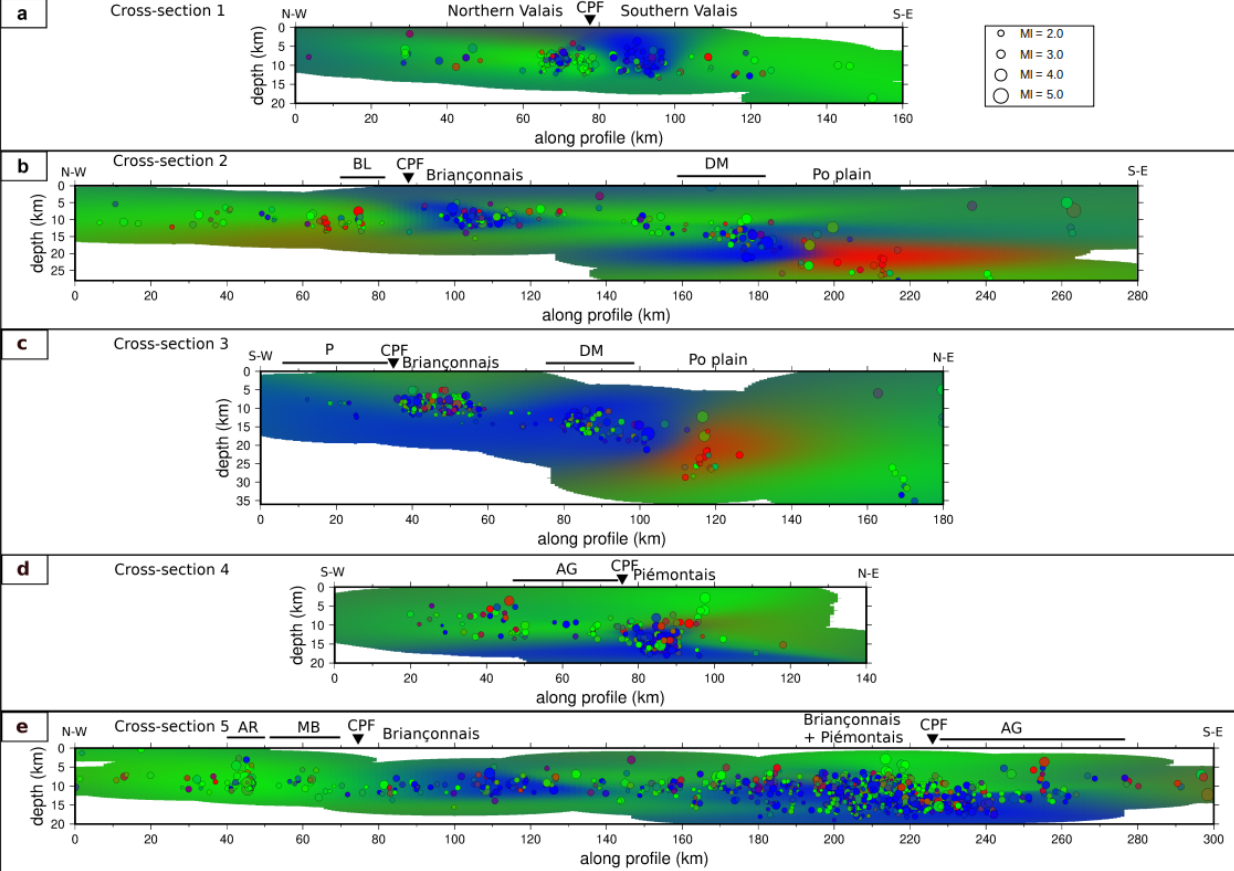
Figure 9. Vertical cross sections displaying averages of P , T , and B distributions from the Bayesian interpolation of events projected along five profiles. Focal mechanisms used are represented as dots with their size depending on their magnitude ( M l ). Profile locations are indicated in Fig. 7. Labels refer to geological features displayed in Fig. 2c. Uncertainties in P and T plunges distributions are available in Figs. S5 and